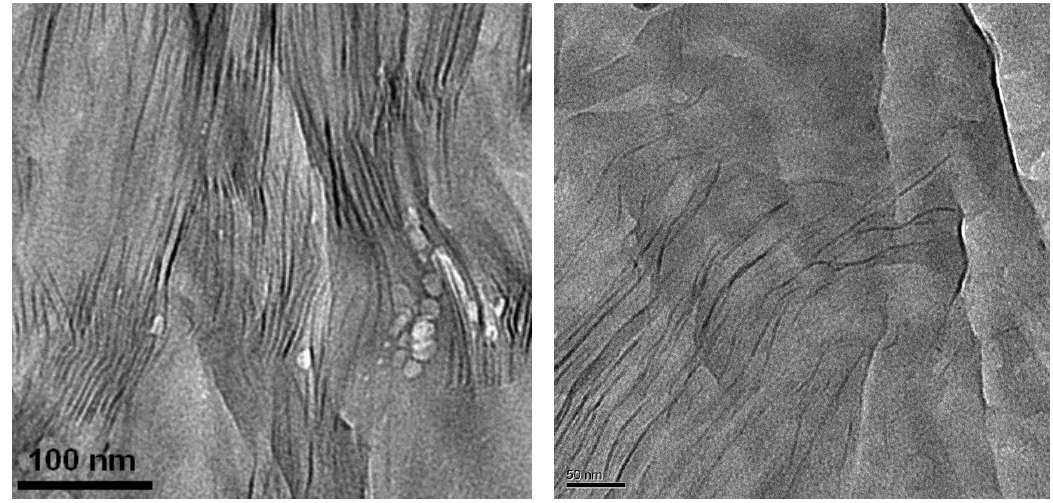
Figure 5: TEM image of PA6/OMMT nanocomposite (3.5 wt.%